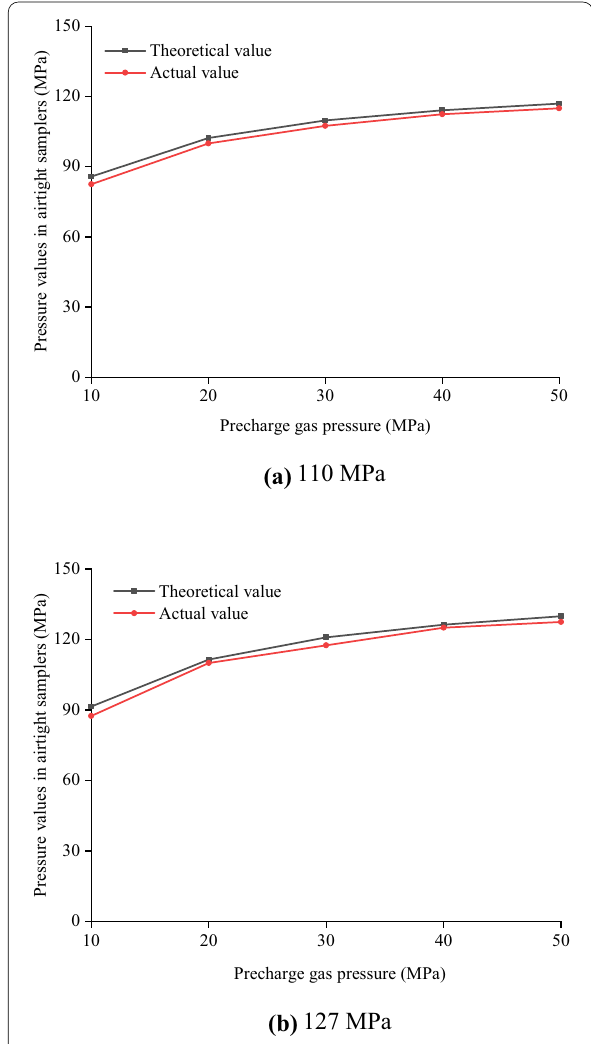
Figure 10 Actual and theoretical values of pressure in GTSS under different precharging